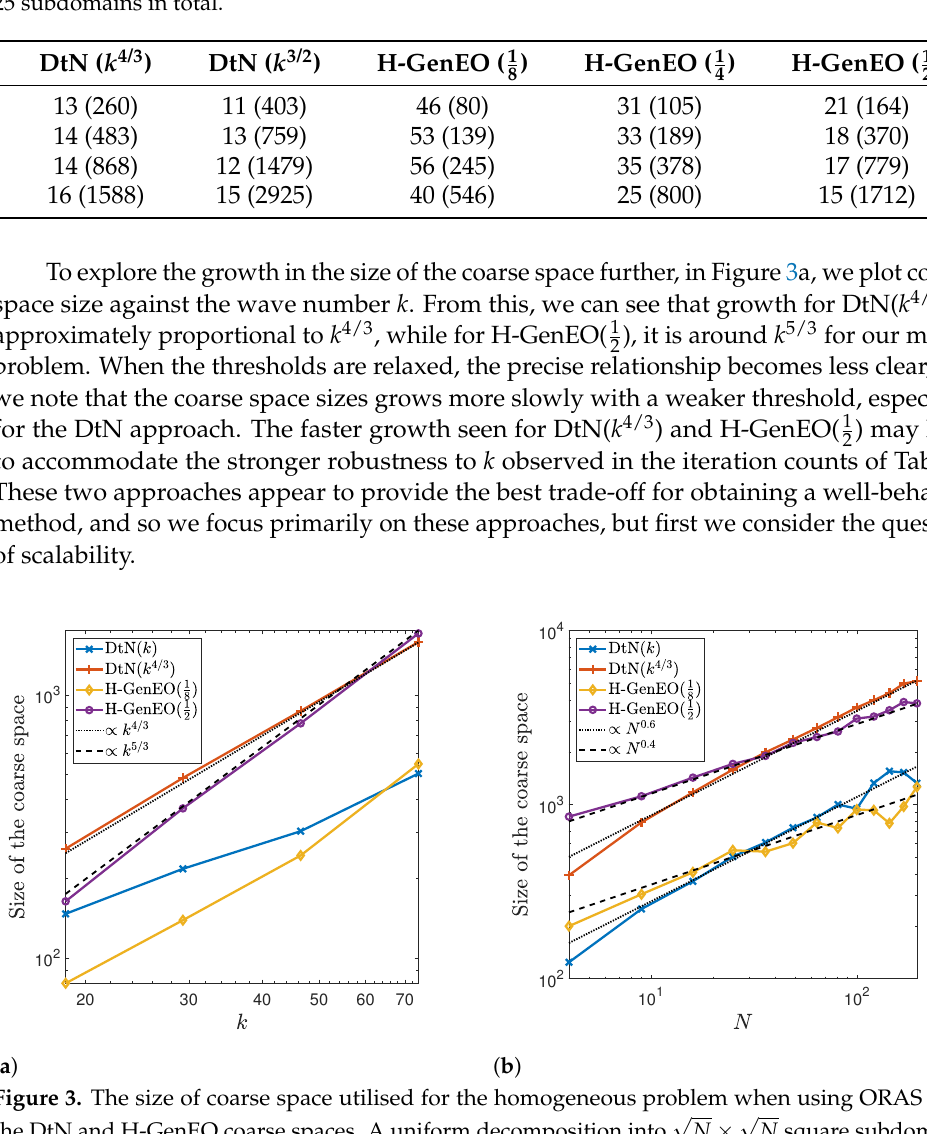
√ √ N × N square subdomains